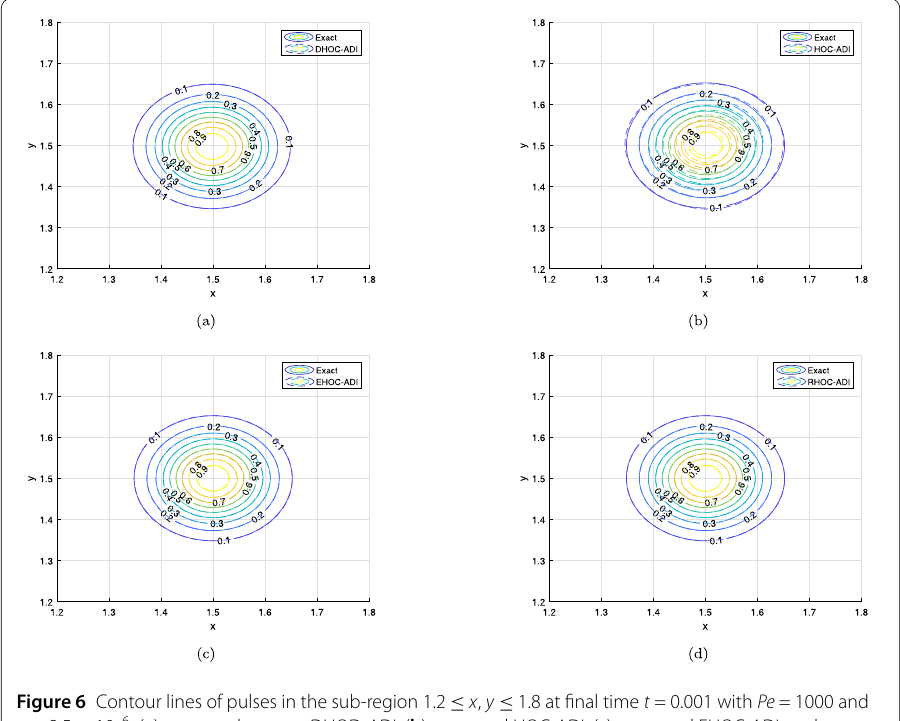
Figure 6 Contour lines of pulses in the sub-region 1.2 ≤ x , y ≤ 1.8 at final time t = 0.001 with Pe = 1000 and τ = 2.5 × 10 –6 : ( a ) exact and present DHOD-ADI, ( b ) exact and HOC-ADI, ( c ) exact and EHOC-ADI, and ( d ) exact and RHOC-ADI. Dash-dot contour lines in ( a )–( d ) correspond to numerical solutions